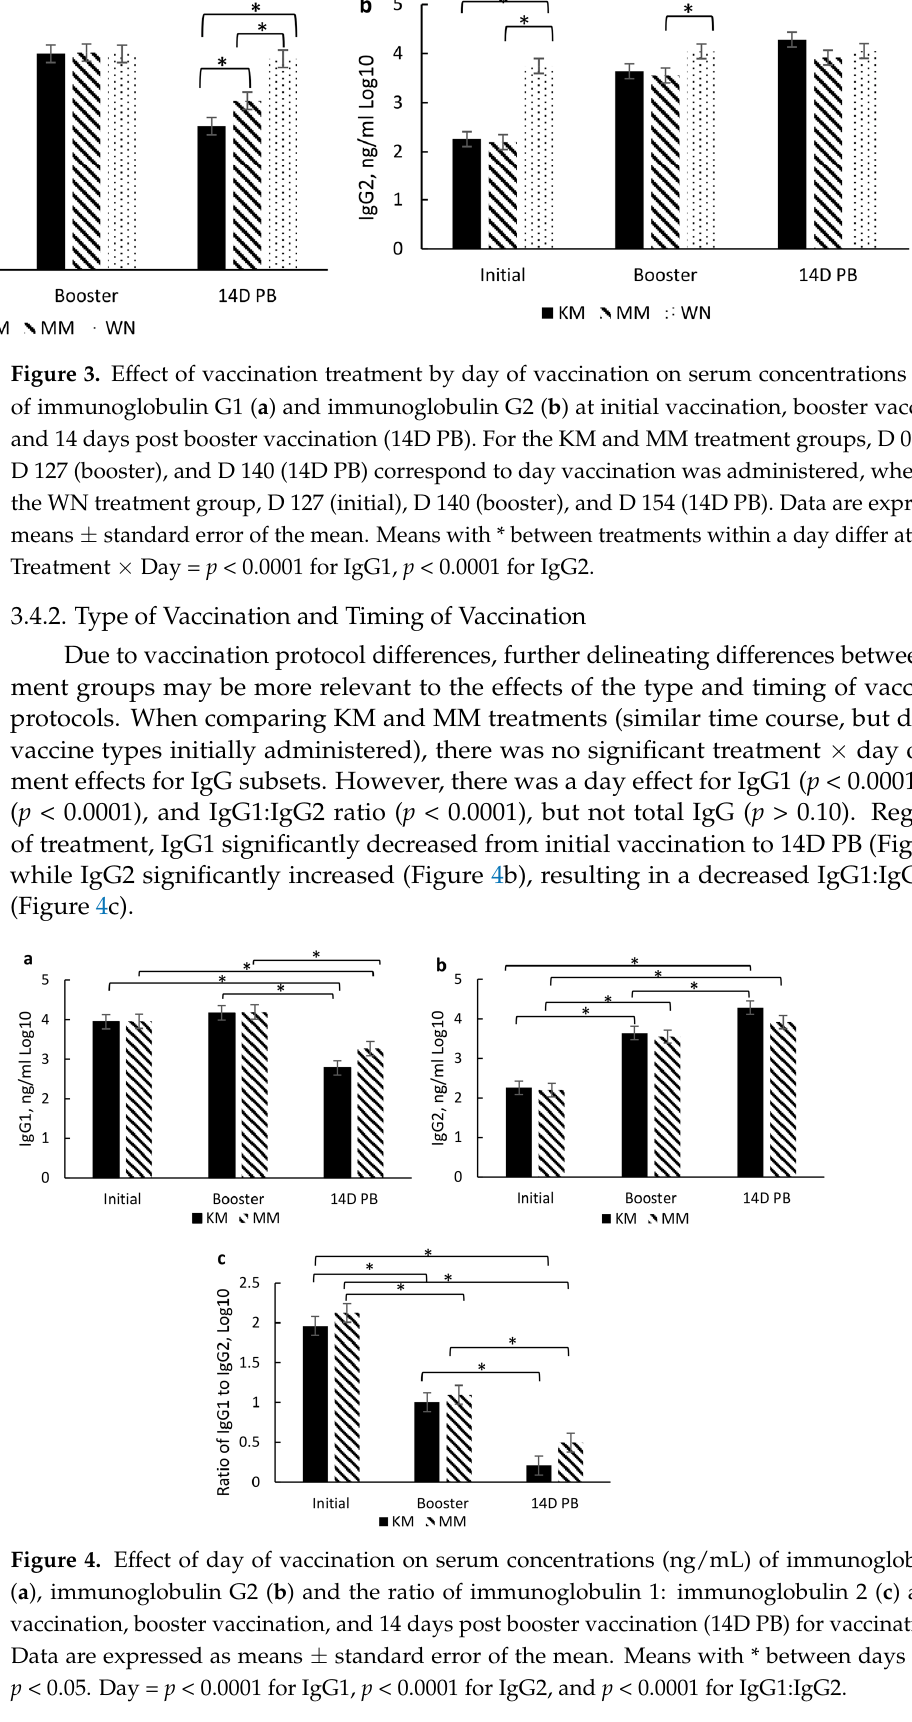
8 of 15 Figure 2. Least square means Log2 BVD antibody titers for treatment × day interaction in calves vaccinated with either an inactivated or modified-live viral BRD vaccine. Vaccines were adminis- tered for KM at d 0 (KV) and 127 (MLV), MM at d 0 (MLV) and 127 (MLV), and WN on d 127 (MLV) and 140 (MLV). KV = killed vaccine (ViraShield 6, Elanco Animal Health, Greenfield, IN). MLV = modified-live viral vaccine (Titanium 5, Elanco Animal Health, Greenfield, IN). a–c Least square means with differing superscripts differ by p < 0.05. 3.4. ImmunoglobulinG and Subsets Response to Type and Timing of Vaccines 3.4.1. Overall Effects of Treatment In this section, days refer to the time between initial vaccination, booster, and 14 days post booster (14D PB). A significant treatment x day of vaccination occurred for IgG1 ( p < 0.0001) and IgG2 ( p < 0.0001) concentrations (Figure 3) but not for total IgG or IgG1:IgG2 ratio (data not shown). The KM and MM groups had significantly higher IgG1 concentra-